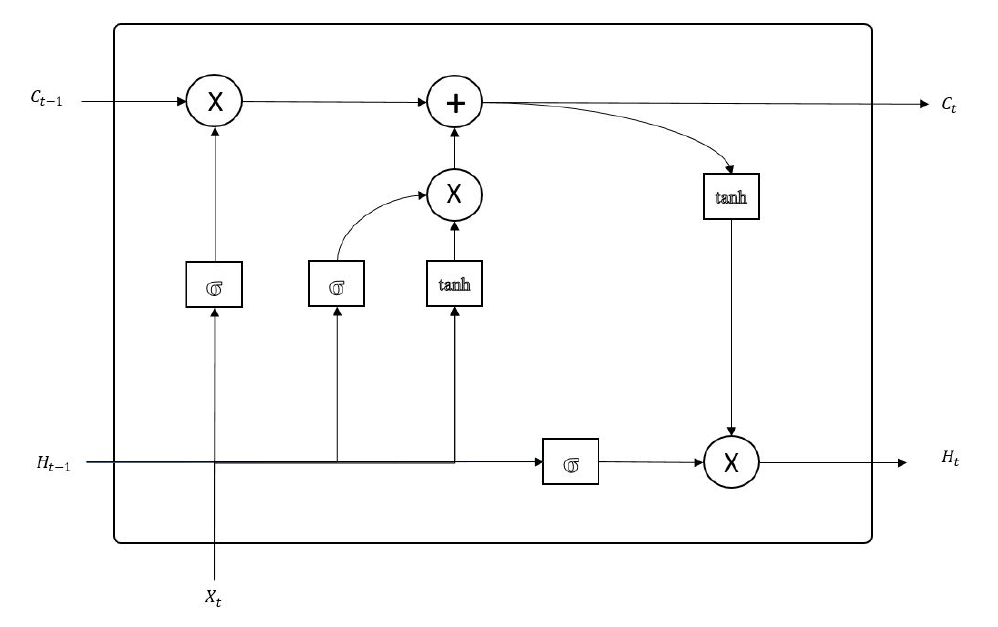
Figure 1. Figure